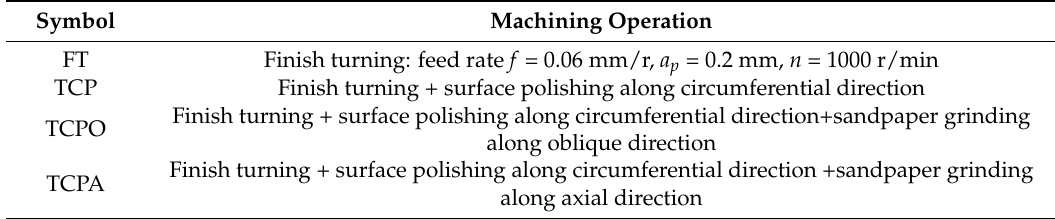
Table 1. Machining processes for each